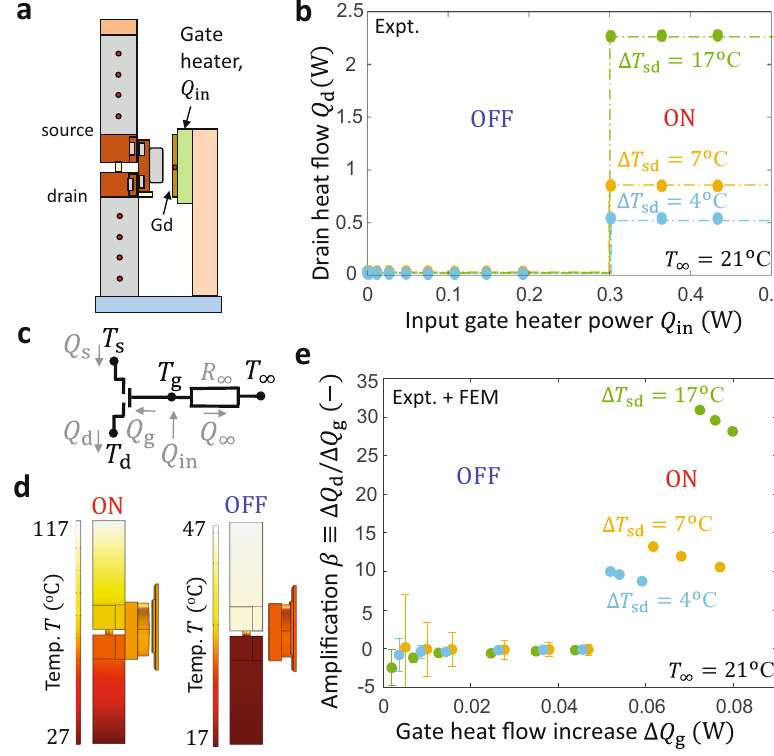
Fig. 3 | Transistor heat fl ow ampli fi cation. a The transistor can use a small gate heat fl ow Q g to drive a large source-drain heat fl ow. To quantify this thermal ampli fi cation, we mount the Gd on a heater and use the reference bar method in vacuum to measure Q d as a function of the gate input power Q in . b A gate input power of Q in =0 : 3W heats the gate above T off (cid:3) on and drives drain heat fl ows as large as Q d =2 : 2 W at Δ T sd =17°C. At Q in <0 : 2W and T g < T off (cid:3) on the transistor is OFF forall Δ T sd . Lines are guides to the eye. c The truegate heat fl ow Q g is smaller than Q in due to thermal losses to the surroundings Q 1 , as illustrated in a thermal